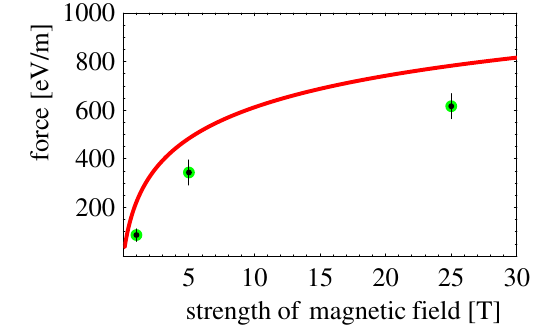
FIG. 5. (Color) Longitudinal friction force ( eV = m ) for (cid:3) (cid:5) (cid:2) 3 (cid:6) 10 5 ; 0 (cid:3) m = s vs magnetic field B (T), for (cid:2) V ; V ion ; k ion ; ? the finite-temperature electron beam with ( (cid:1) 10 5 ; 1 (cid:6) 10 7 (cid:3) m = s . Solid curve—Eq. (9); dots with error bars— VORPAL results.